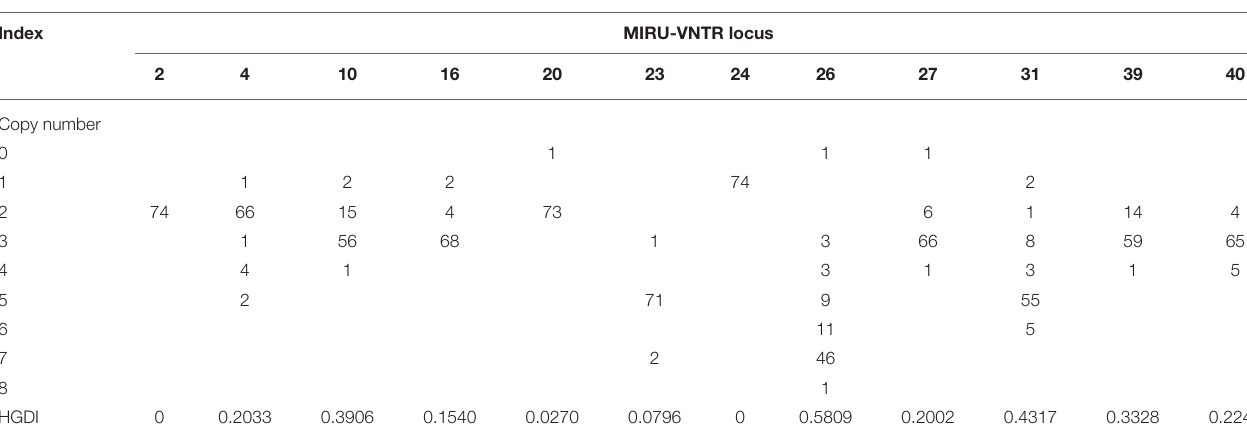
TABLE 3 | Resolution of each polymorphic site for 37 paired